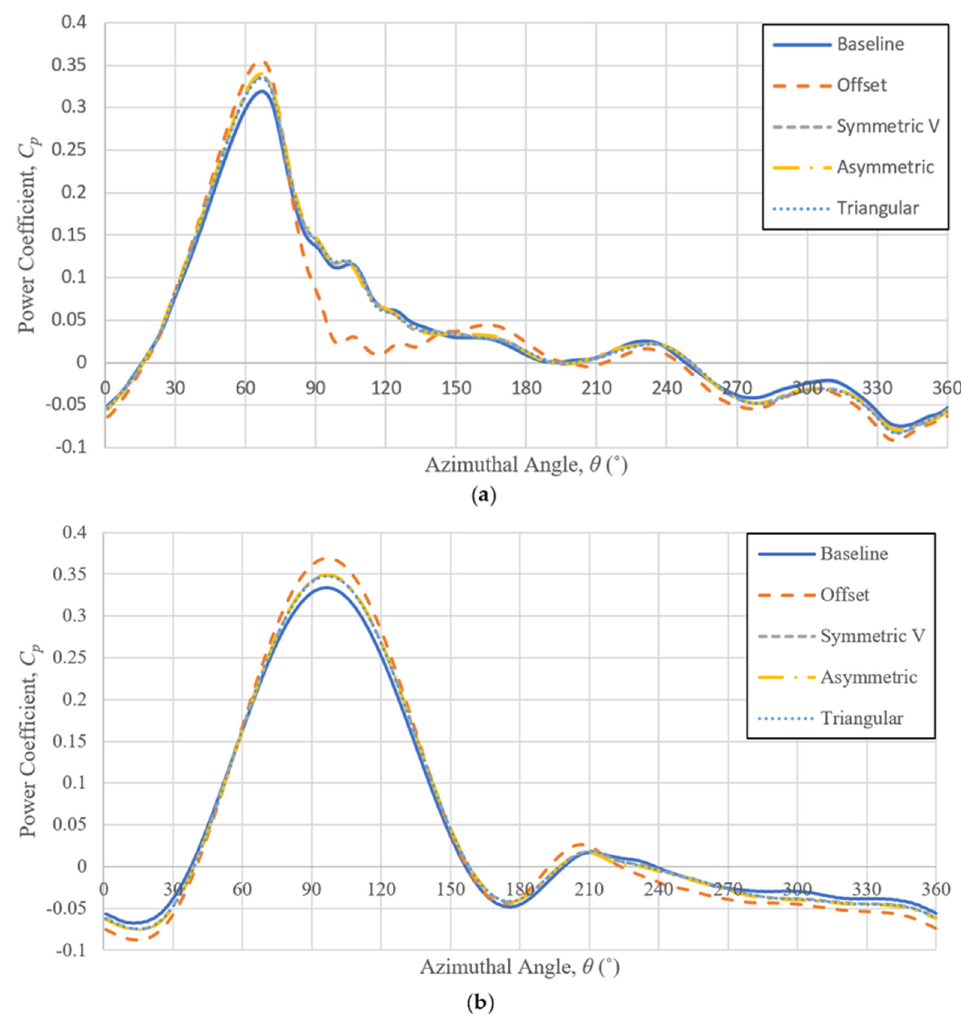
Figure 9. Vorticity of ( a ) baseline; ( b ) offset endplate at θ = 90° in TSR 1.